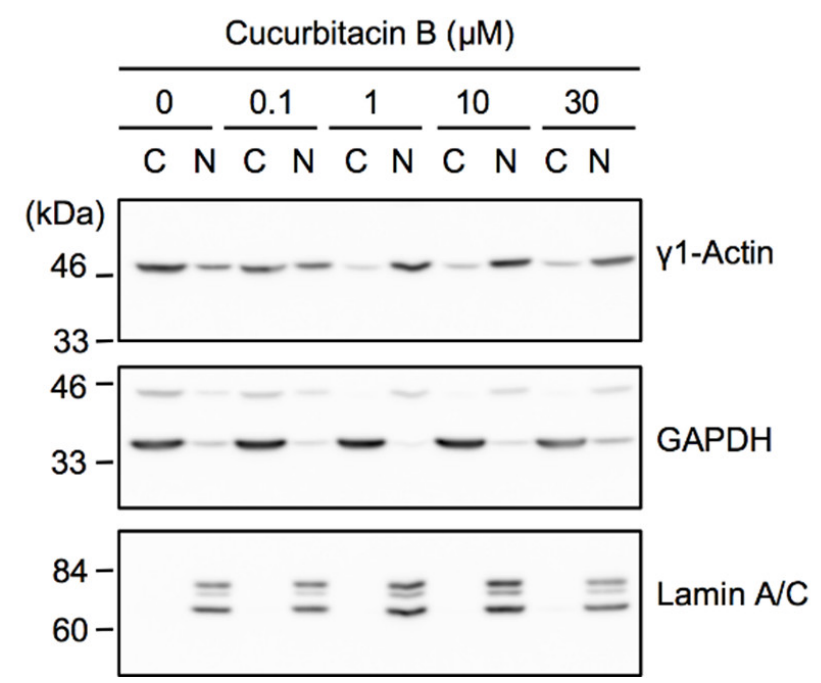
Figure 9. Cucurbitacin B decreased γ1-actin in cytoplasmic fractions. A549 cells were treated with the indicated concentrations of cucurbitacin B for 1 h, followed by the preparation of cytoplasmic (C) and nuclear fractions (N). Blots are representative of two independent experiments.